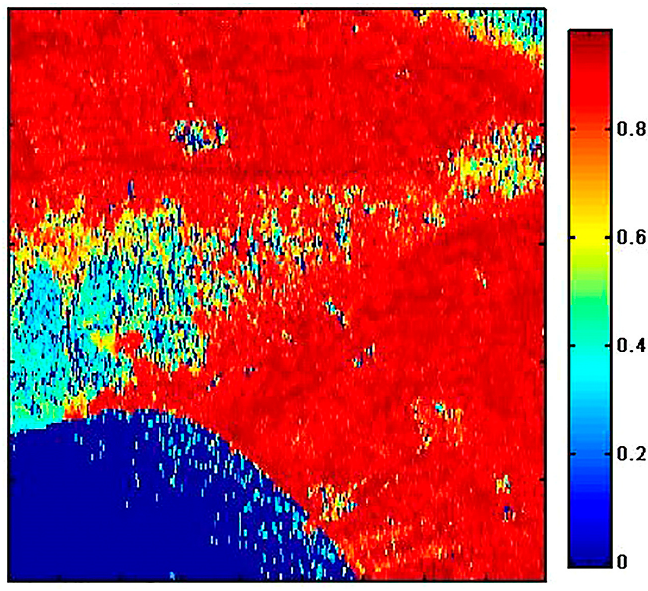
Figure 3. The coherence map obtained in PSInSAR analysis in the study area.